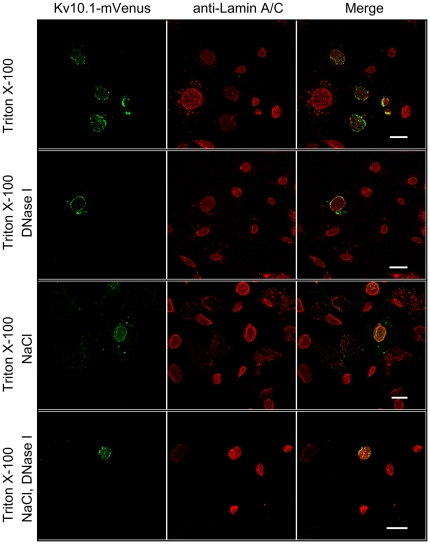
Epitope masking of Lamin A/C in the presence of KV10.1.CHO cells transiently expressing KV10.1-mVenus (green) were extracted in Triton X-100 (top panel) plus either DNase I (second panel from top), NaCl (third panel) on ice, or DNase I plus NaCl (bottom panel) at 37°C. Cells were then stained with anti-lamin A/C antibodies (red). Note the reduced lamin A/C fluorescence in the upper panel and the rescue in the other three panels. Scale bar, 20 µm.